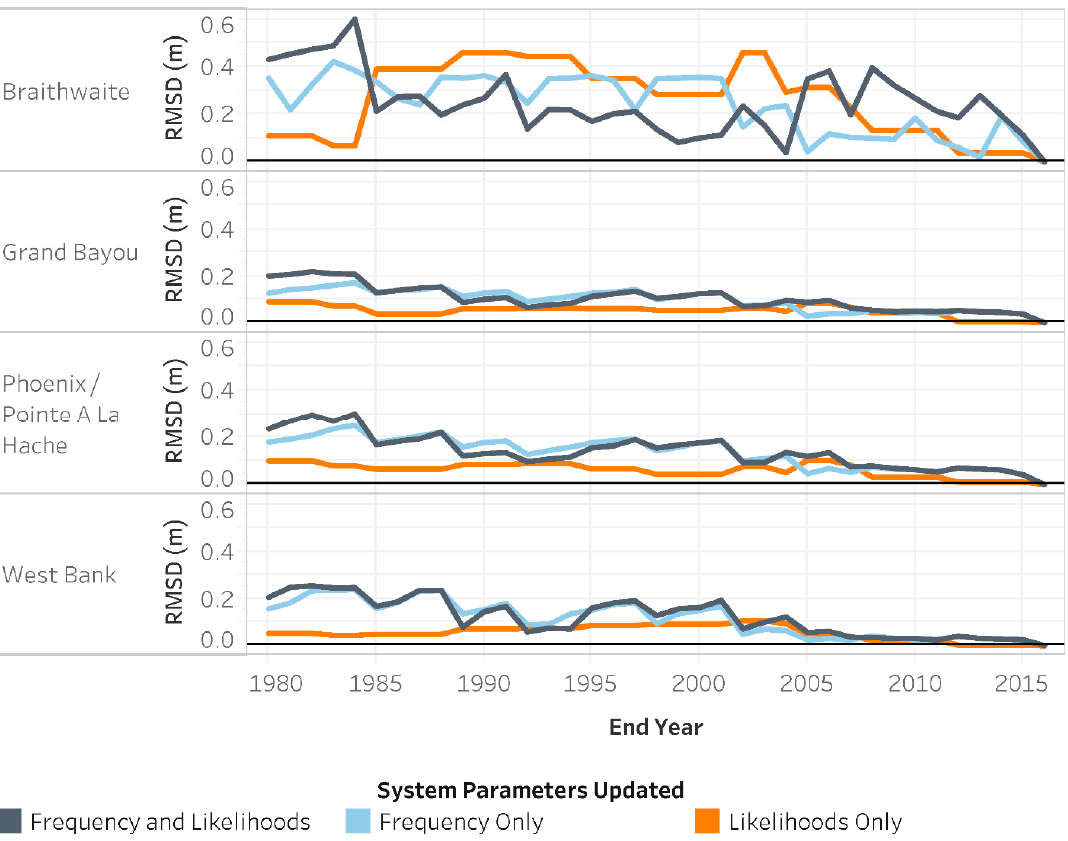
Figure 4. Root mean squared deviation (RMSD) of 100-year flood depth predictions over time, with Plaquemines Parish risk regions exterior to the Greater New Orleans Hurricane & Storm Damage Risk Reduction System